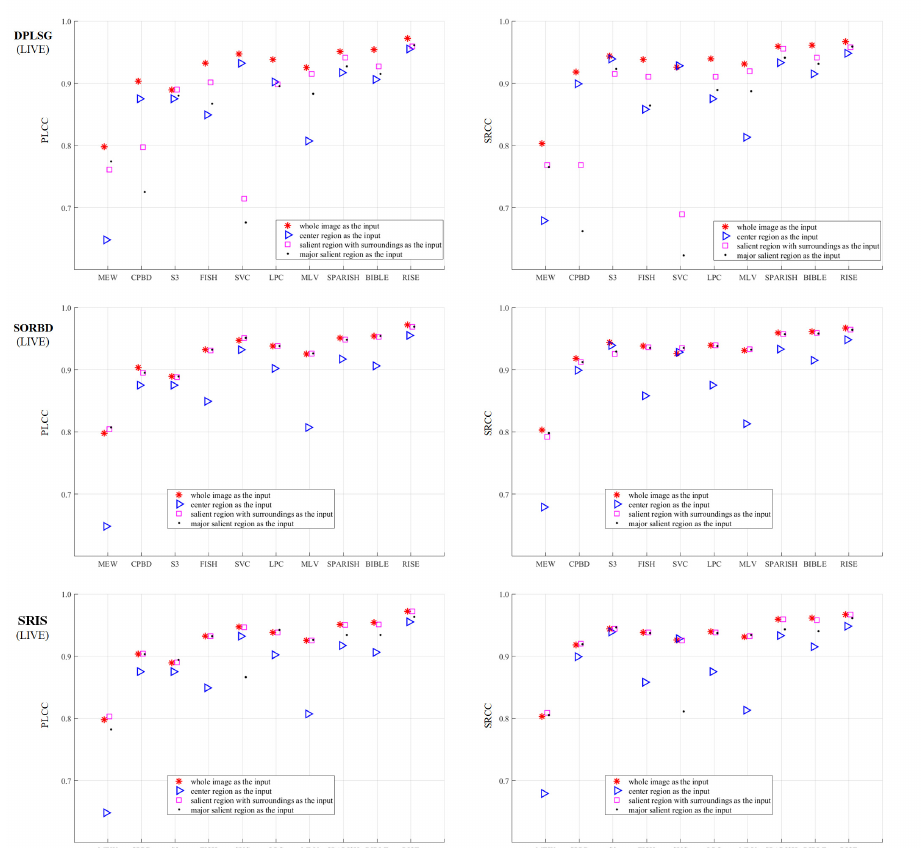
Figure 5. Comparison of BSIA results with different inputs from SRD methods on the LIVE Gaussian blurring images. This shows that the SR ( (cid:3) ) or the mSR ( · ) input could achieve comparable results to the WI input ( ∗ ), and the CR ( (cid:52) ) input leads to the worst prediction performance. (The figure can be enlarged for